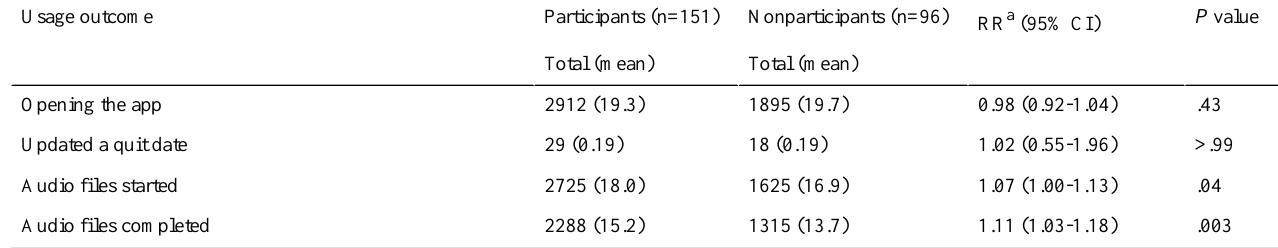
Table 2. Comparison of app usage outcomes from Google Analytics for participants and nonparticipants. Total: Aggregate count. Mean: Average per user. RR: rate ratio (exact Poisson test), with test for equal rates. Counts of audio files started and completed include both repeated usages of the same files and usages of different files by an